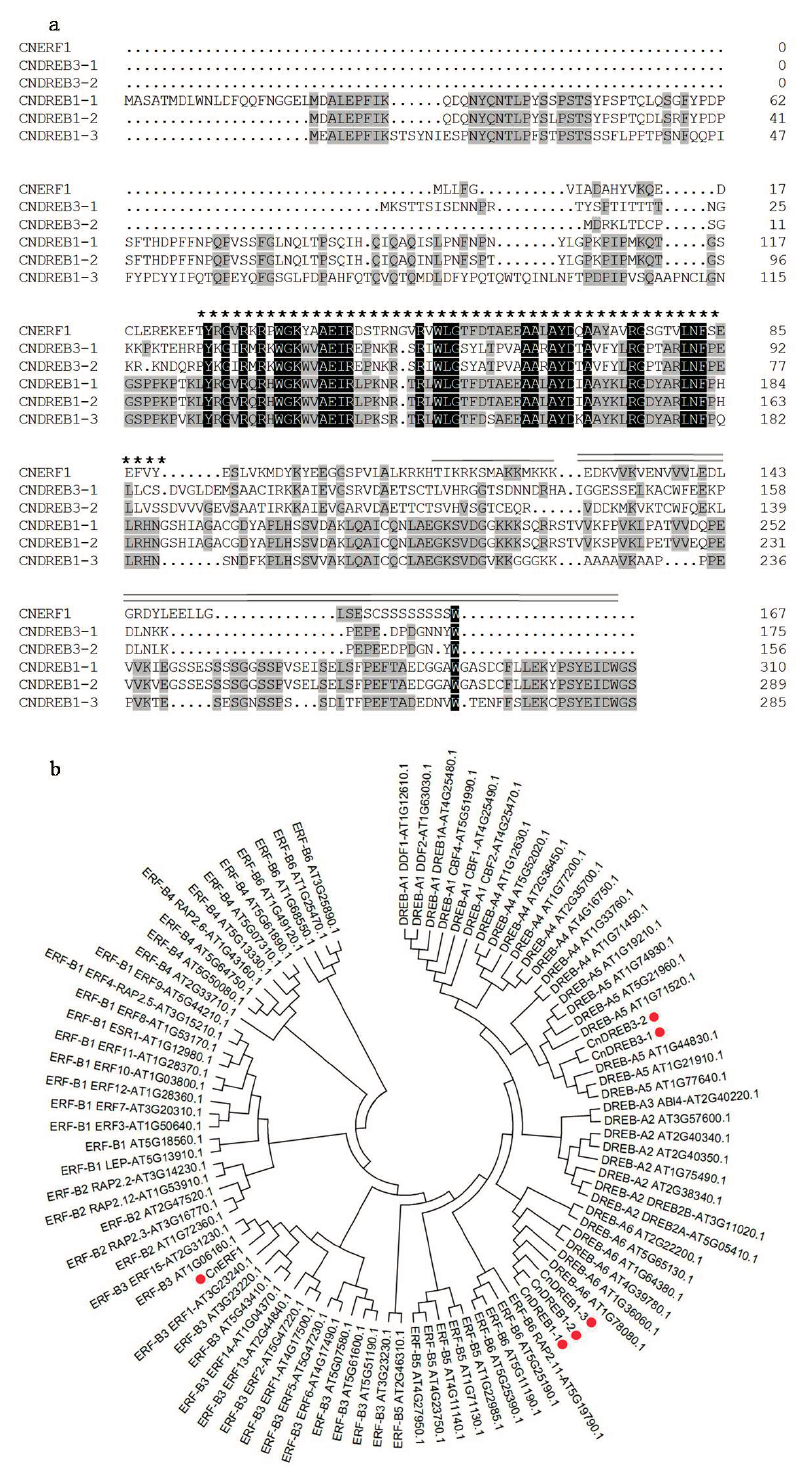
Figure 1. Deduced peptide sequences of the CnAP2/ERF transcription factor (TF) products and their phylogenetic relationship with A. thaliana homologs. ( a ) The deduced polypeptide sequences; residues shared by at least three of the six sequences are shown shaded, whereas those conserved across all six polypeptides are marked in dark grey. Asterisks indicate the conserved DNA-binding AP2/ERF domain, a double overline indicates the putative acidic domain and a black underline indicates the putative nuclear localization signal; ( b ) Phylogeny of the CnAP2/ERF TF products. Dots indicate likely